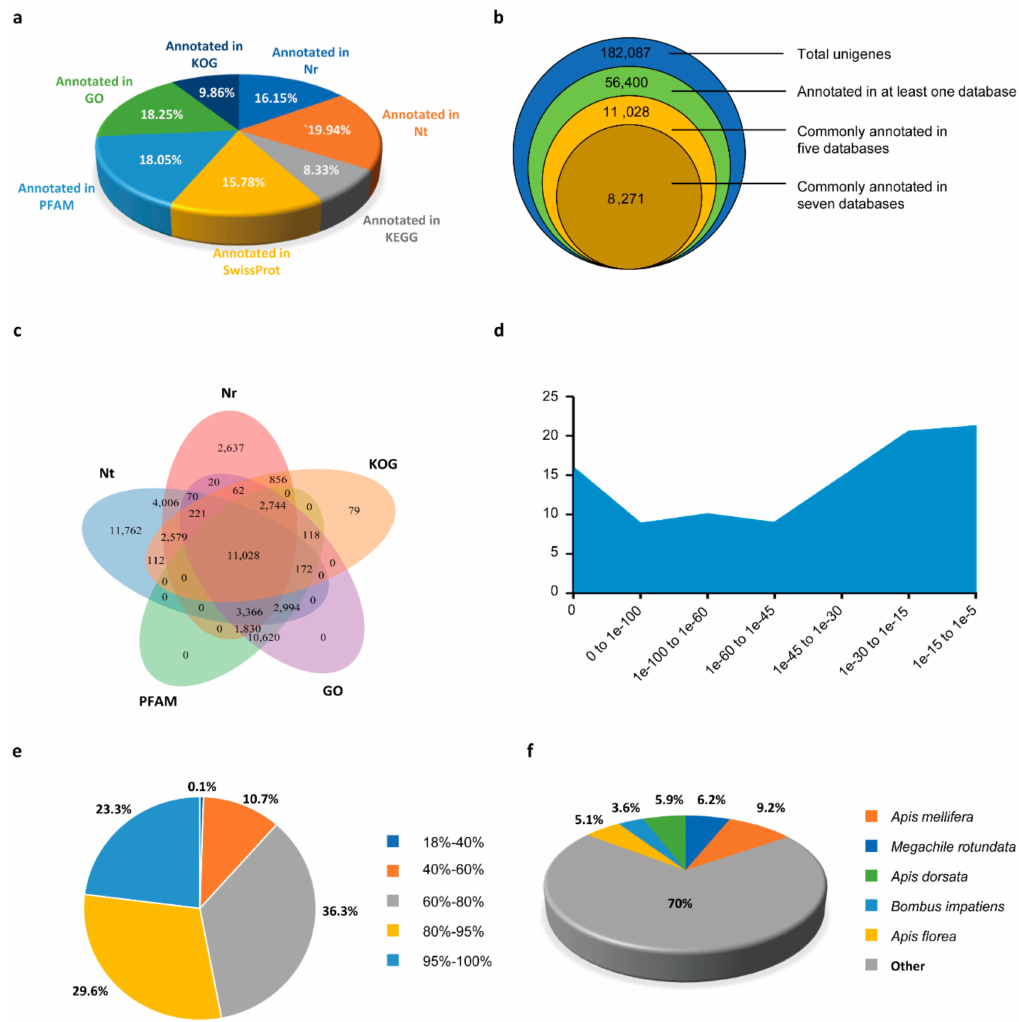
Figure 2. Functional annotation of unigenes from Vespa velutina transcriptome. ( a ) Summary of the annotation by the seven databases. Nr, NCBI non-redundant protein sequences; Nt, NCBI nucleotide sequences; PFAM, Protein family; KOG, euKaryotic Ortholog Groups; SwissProt, UniProt Knowledgebase; KEGG, Kyoto Encyclopedia of Genes and Genomes; GO, Gene Ontology; ( b ) Statistics of the number of unigenes annotated by single or multiple databases; ( c ) Venn diagram for annotations in the five databases; ( d ) E-value distribution of BLAST hits against the Nr database; ( e ) Similarity distributions of the top BLAST hits against the Nr database; ( f ) Species distribution of the top BLAST hits against the Nr